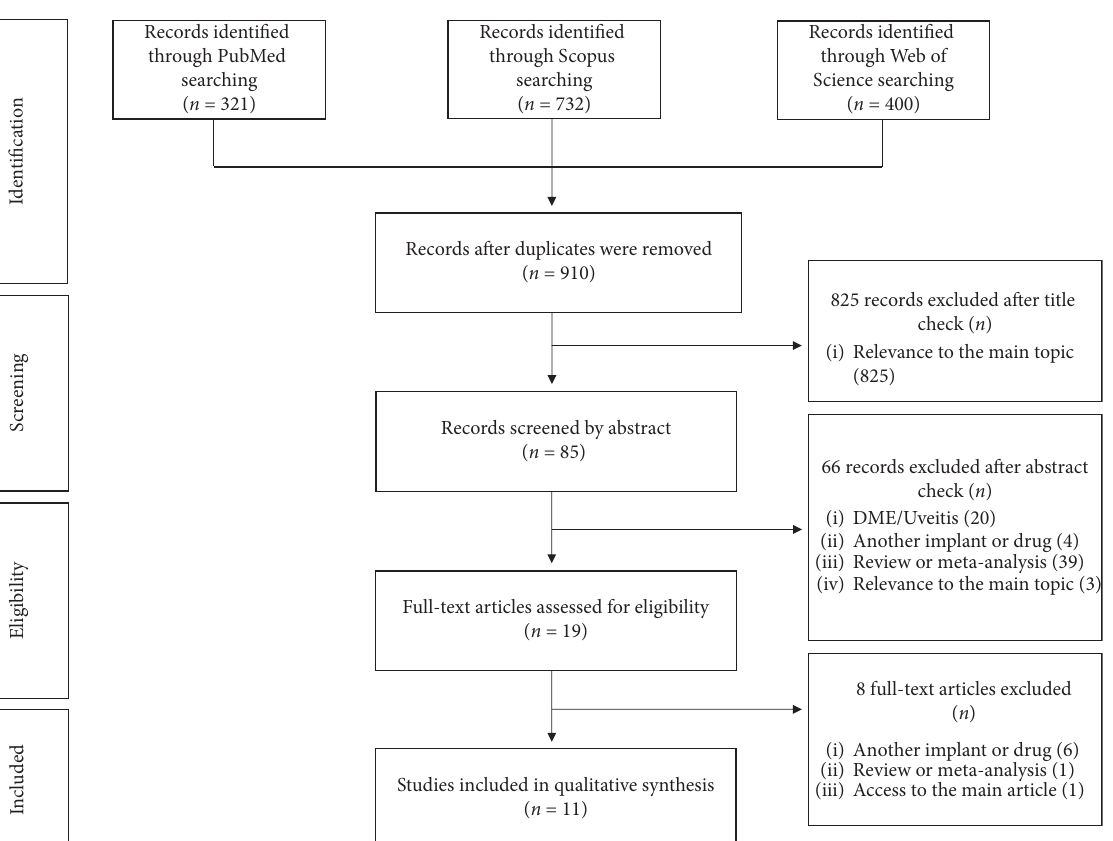
Figure 1: Flowchart, adapted from PRISMA [19], summarizing the selection process for studies concerning off-label FAc implant in ophthalmological